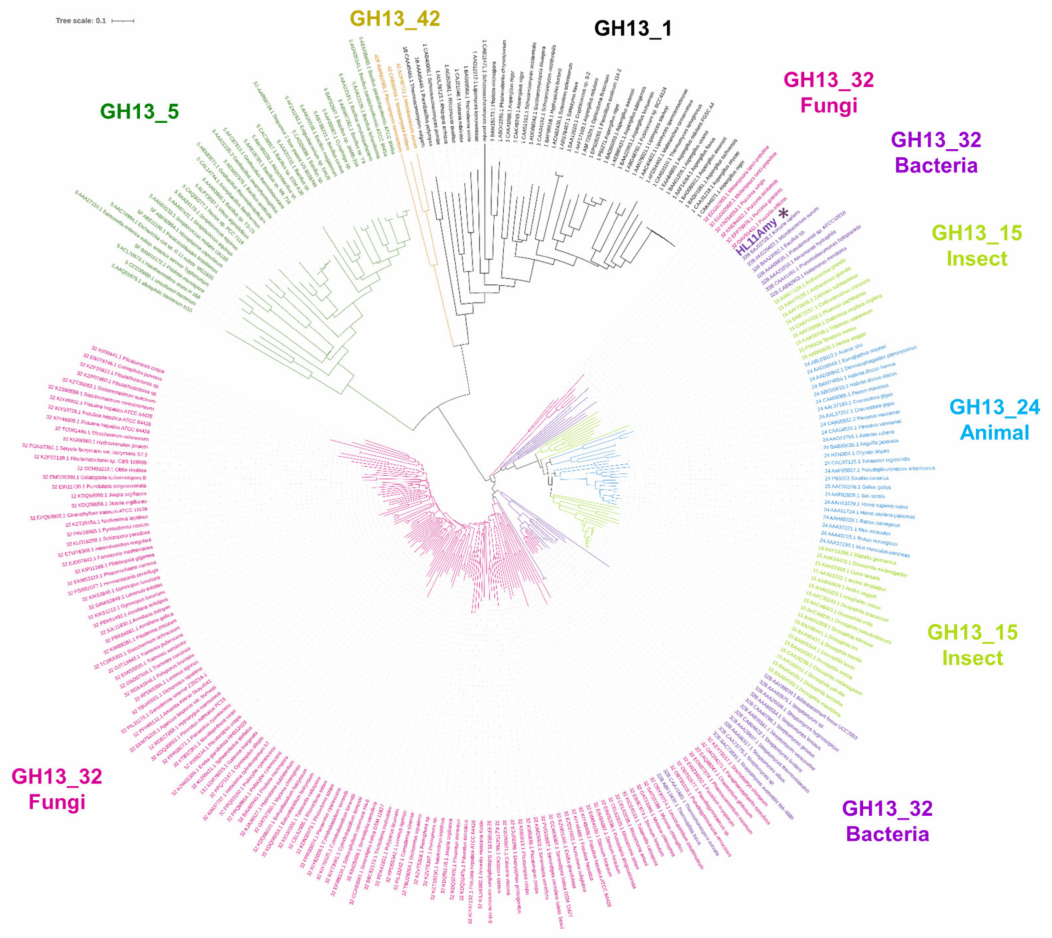
Figure 1. Phylogenetic tree based on amino sequence alignment of HL11Amy and 268 related α - amylase members in various subfamilies of GH13 obtained from Jan í ˇckov á and Janeˇcek (2021). The neighbor-joining tree was constructed using the MEGA version 11, using the bootstrap method for estimation of phylogenetic evolution via number of bootstrap replications,